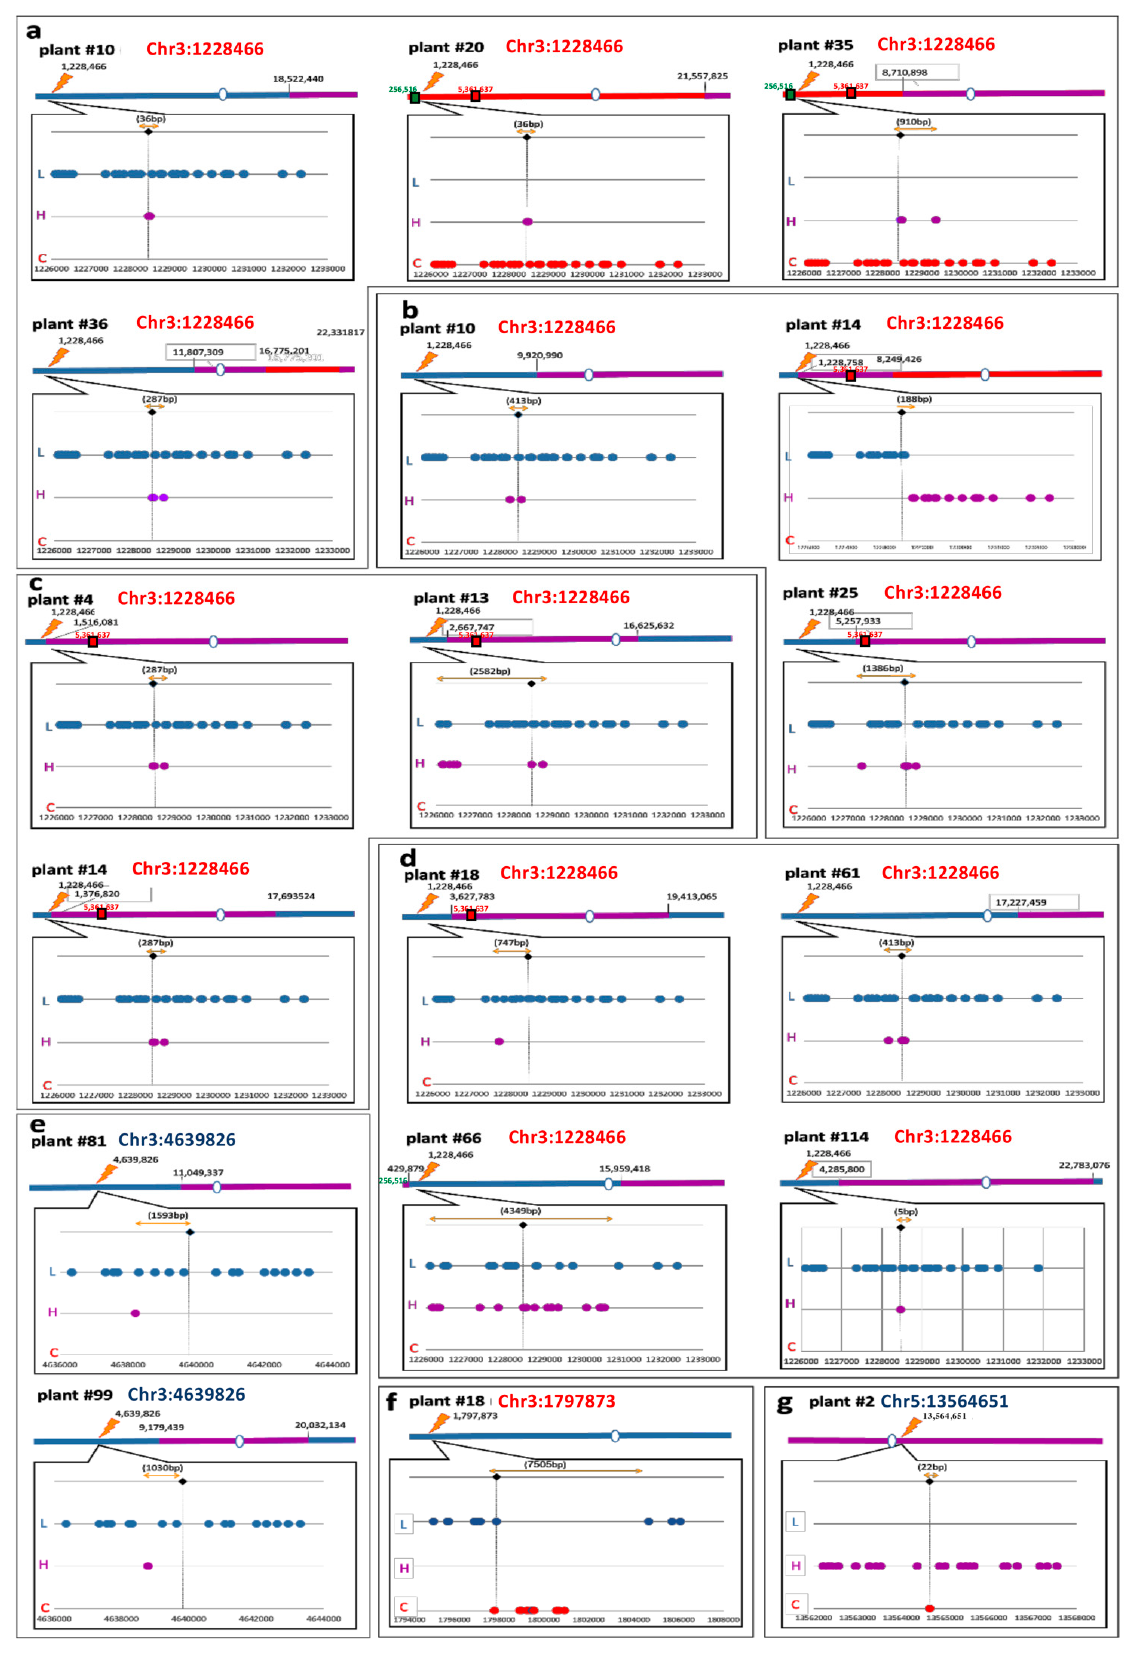
Figure 2. Targeted IHR Events. Maps of recombinant F2 plants. The chromosome# and coordinates of each target